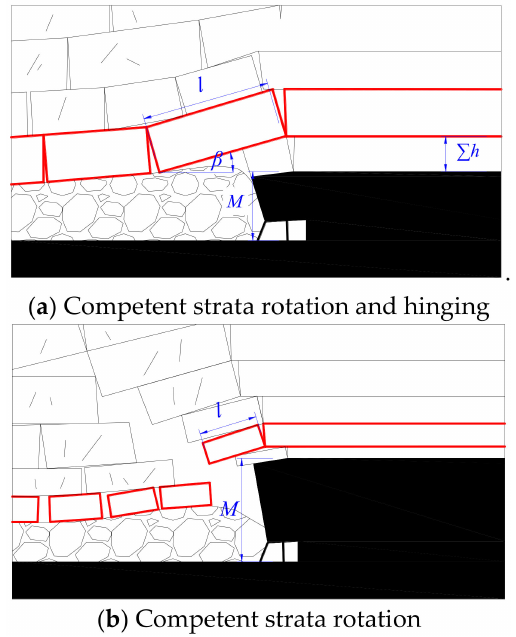
Figure 10. Rock block rotation after the 1st layer